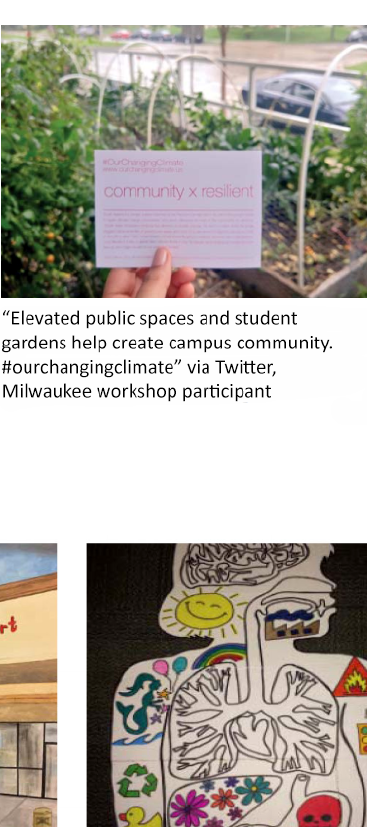
Figure 3. Food-related posts.